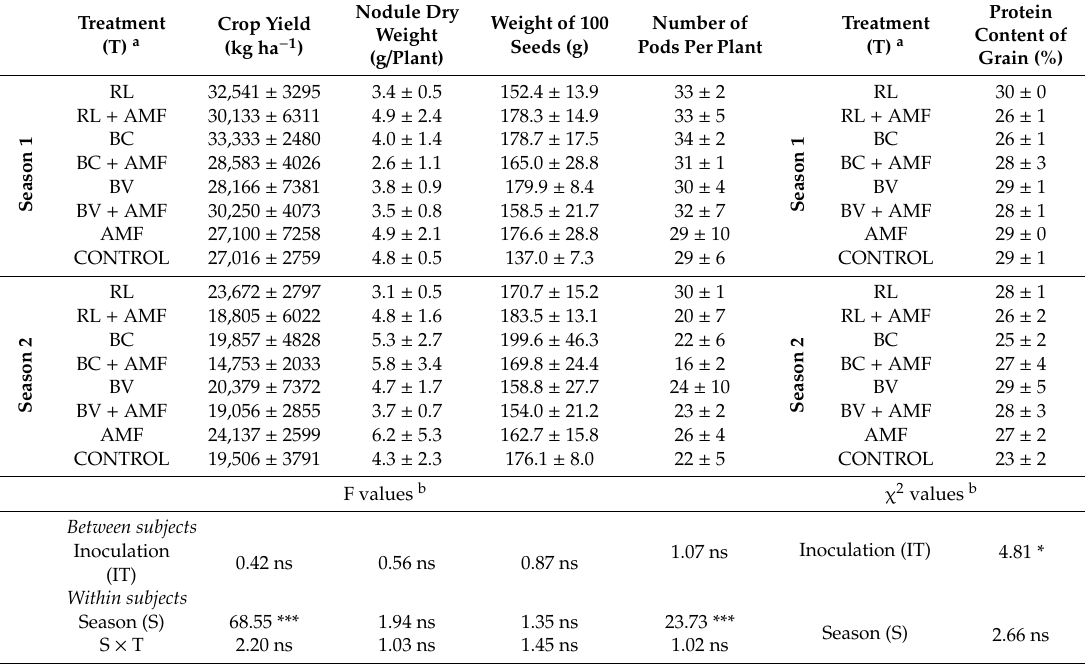
Table 5. Crop yield, dry weight of nodules and crop quality parameters (weight of 100 seeds, number of pods per plant and protein content of grain). Values shown are mean ± standard deviation ( n =